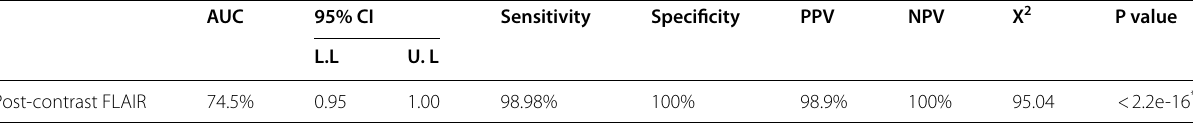
AUC: area under the curve, CI: confidence interval, LL: lower limit, UL: upper limit, PPV: positive predictive value, NPV: negative predictive value